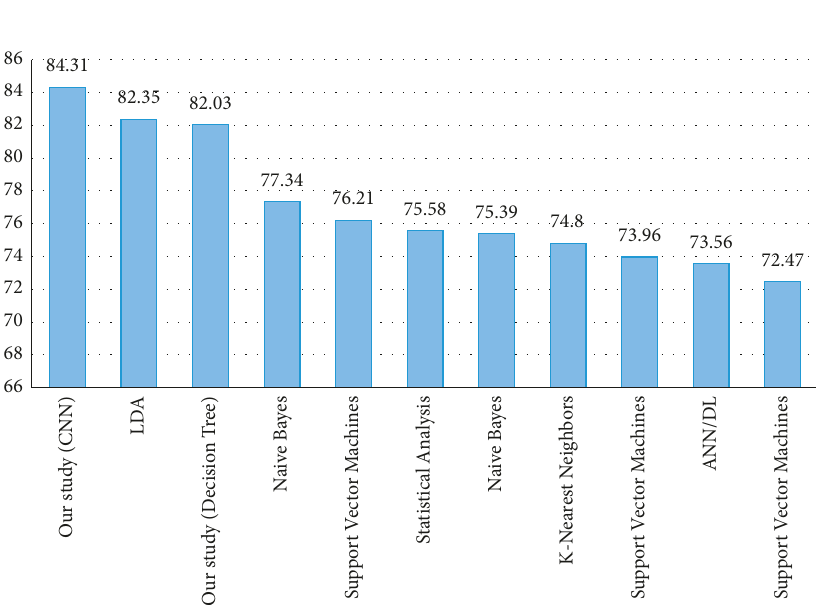
Figure 7: Accuracy values of related